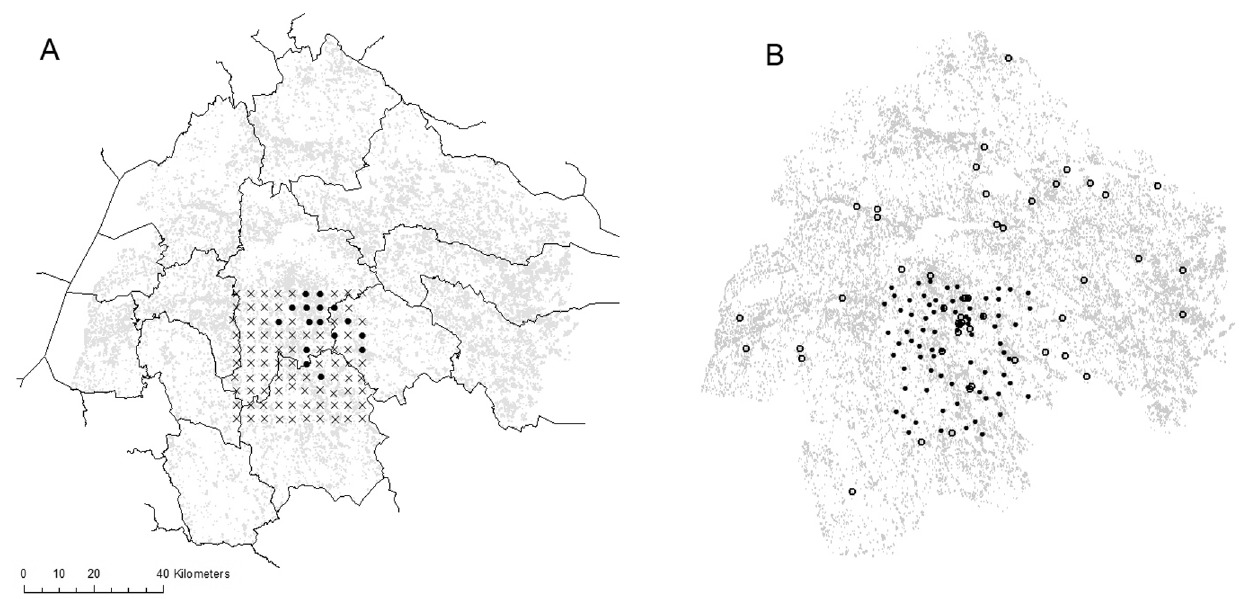
N ) represent occurrence of E.